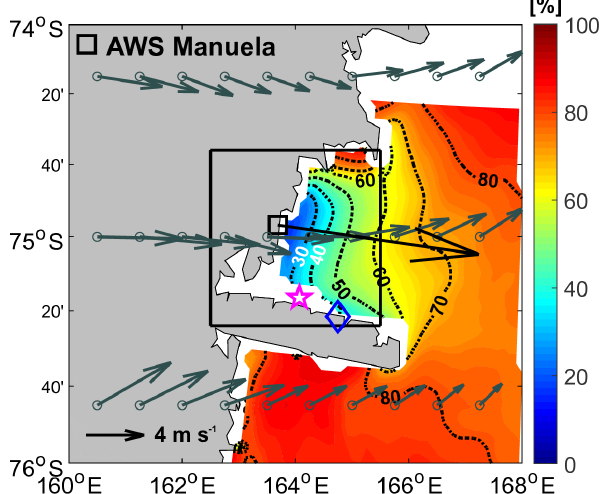
Figure 3. Spatial distributions of averaged sea-ice concentrations from July 2014 to March 2018. The interval of the dotted contour lines is a concentration of 10%. The black square indicates the auto- matic weather station (AWS) Manuela. The blue diamond and ma- genta star are for the DITN and DITD. The dark gray and black ar- rows are mean wind vectors for July 2014–March 2018 using ERA- Interim data and data from AWS Manuela, respectively. The black box denotes the region over which the sea-ice concentrations are averaged in Fig.